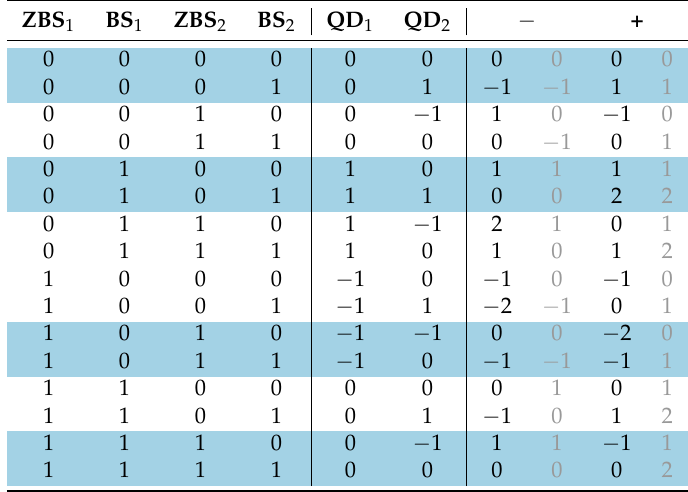
Table 3. Logic table of two bit-streams (BS x ) and their “zero bit-streams” (ZBS x ), the quanta decoded value (QD x ) and the subtraction and addition of the quanta decoded values and direct operated bit-streams. In the highlighted rows, the “zero bit-streams” are